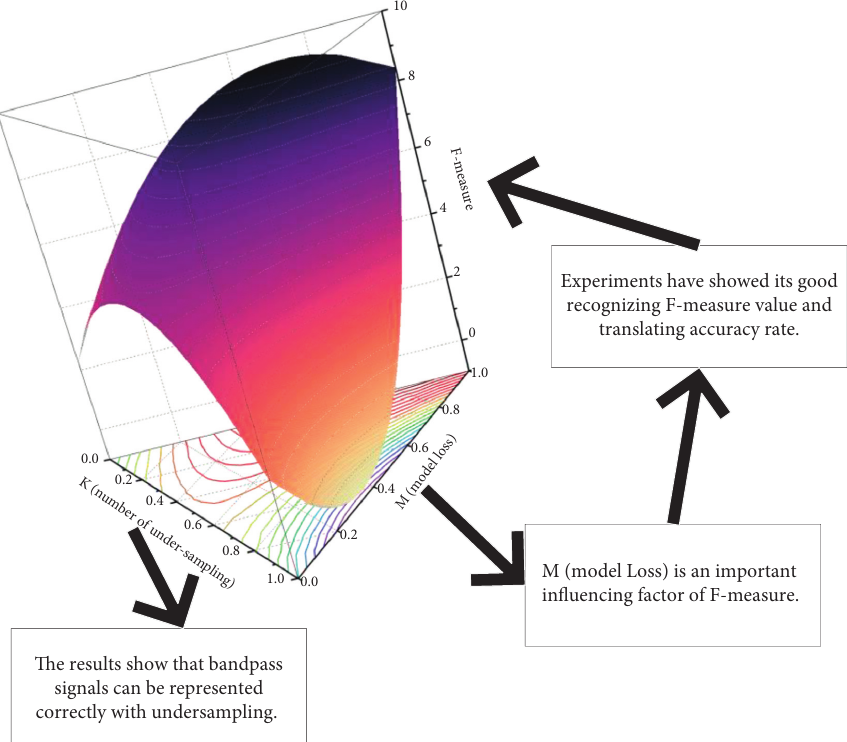
Figure 8: Comparison of model error scenarios.